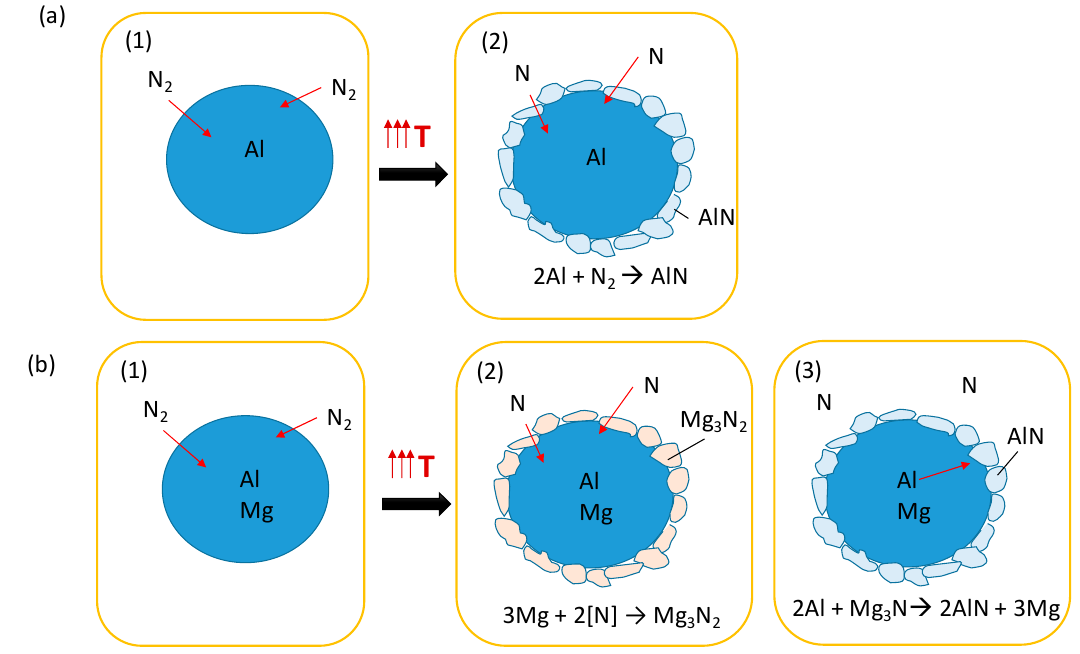
Figure 11. Nitridation mechanism; ( a ) for Al and Al-12Si particles; ( b ) for AA6061 particles.